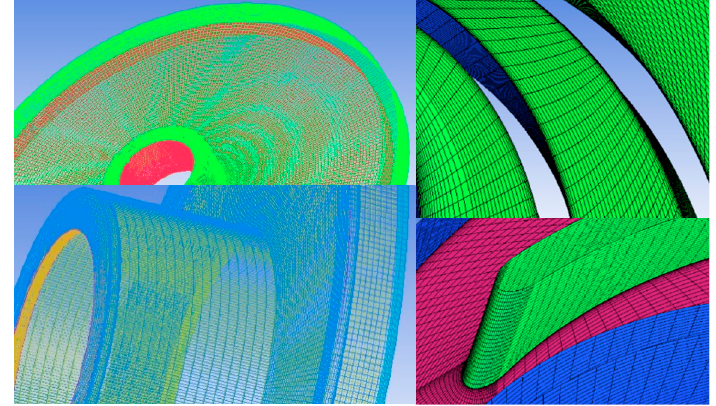
Figure 1. Model view of the pump.